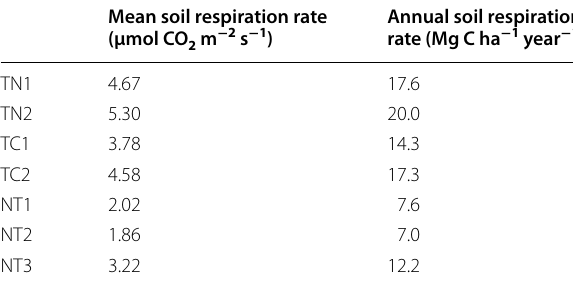
Table 3 Estimated mean soil respiration rate and annual soil respiration rate in 2010 at TN, TC, and NT plantations in